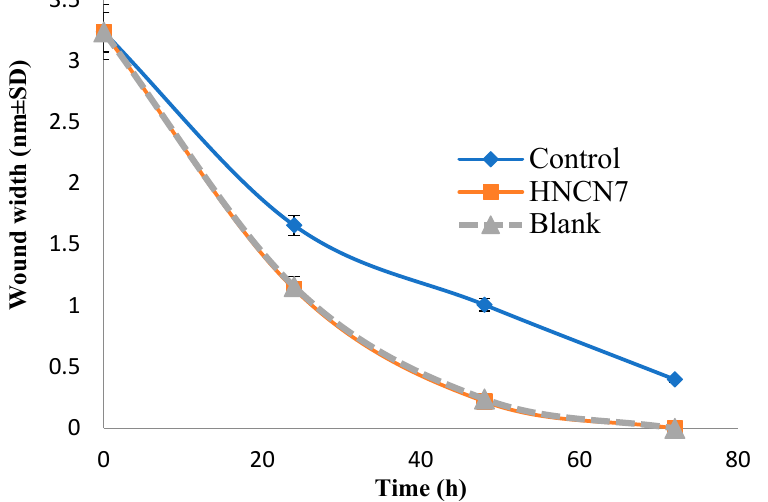
Figure 6. Skin repair micrographs after application of HNCN7 and the unmedicated HNCN7 (blank) for 72 h. (Scale bar = 1 mm).